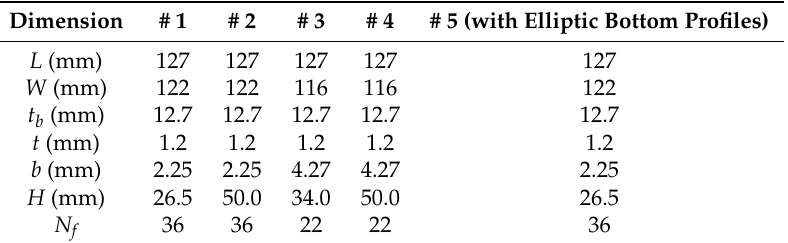
Figure 1. The physical model of the plate fin heat sink. ( a ) Schematic diagram of a plate fin heat sink, ( b ) computational unit of #5 plate fin heat sink. Table 1. Geometry parameters of the plate fin heat sinks.